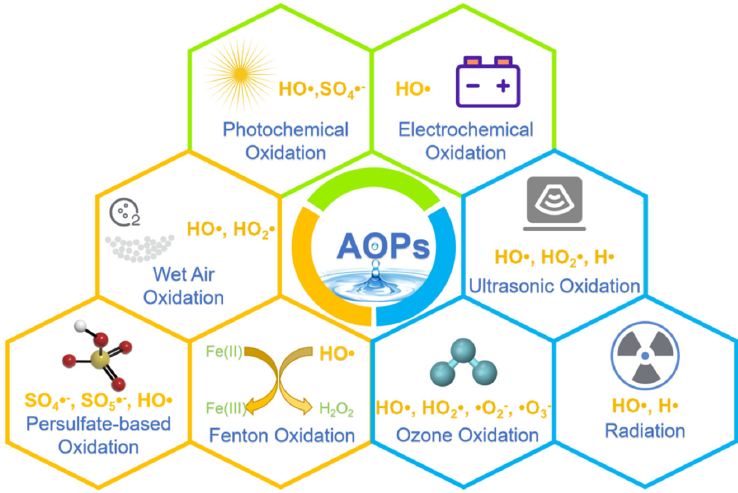
Figure 4. Possible free radicals generated in different